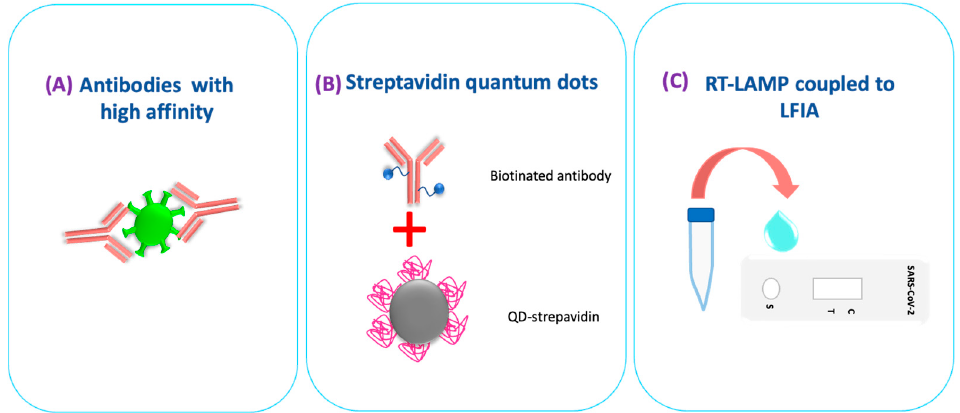
Figure 4. Strategies to improve the detection of SARS-CoV-2 antigens or nucleic acids by Lateral flow immunoassay. ( A ) The sensitivity of LFIAs focuses on developing high-affinity antibodies for the antigen. ( B ) Use of nanomaterials as markers that potentiate the antigen–antibody signal. ( C ) The detection of nucleic acids, incorporating different isothermal amplification techniques.